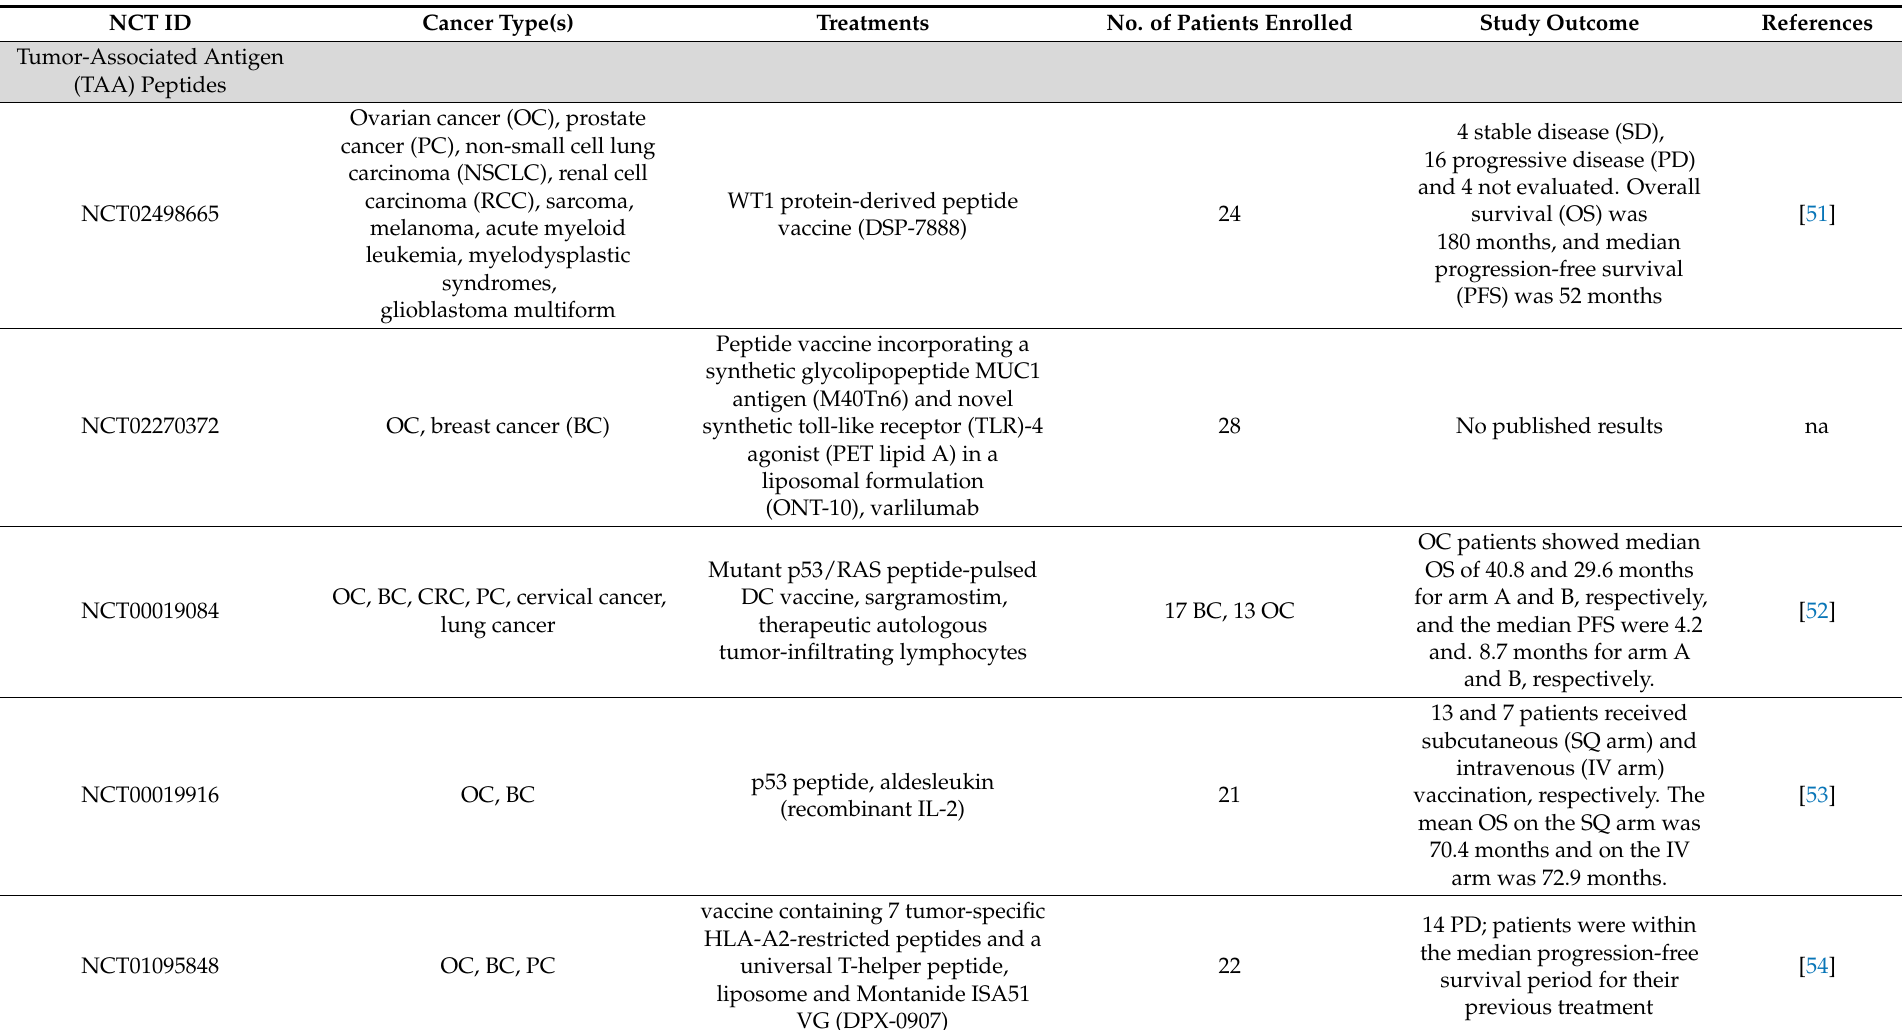
Table 1. Completed OC clinical trials that investigated cancer vaccine strategies. Sources obtained from www.clinicaltrials.gov (accessed on 2 September